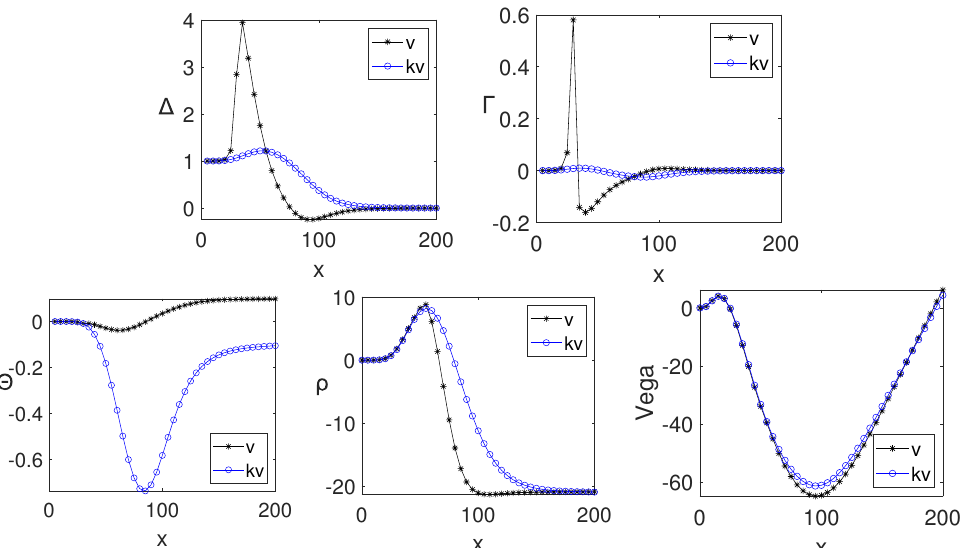
Figure 13. H x = H y = H z = 0.3, figures represent in turn are Delta, Gamma, Theta, Rho and Vega. The blue curve stands for option price with knock-in-barrier while the black curve represents option price without knock-in-barrier. For interpretation of the references to color in the figure, the reader is referred to the web version of the article.